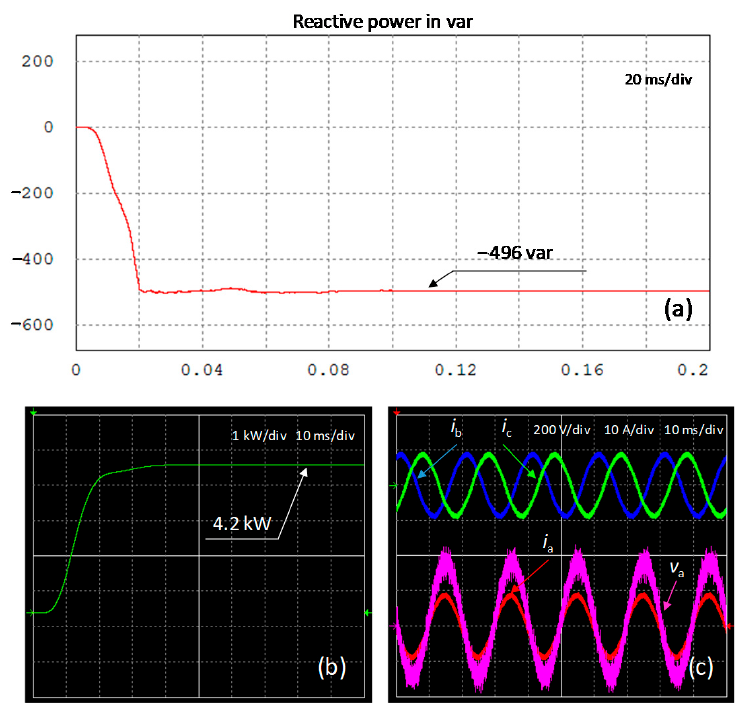
Figure 10. Registered data for reference active current I α ref = 10 A and reference reactive current I β ref = − 1 A: reactive power in var ( a ); active power in W ( b ); grid currents and voltage waveforms ( c ).